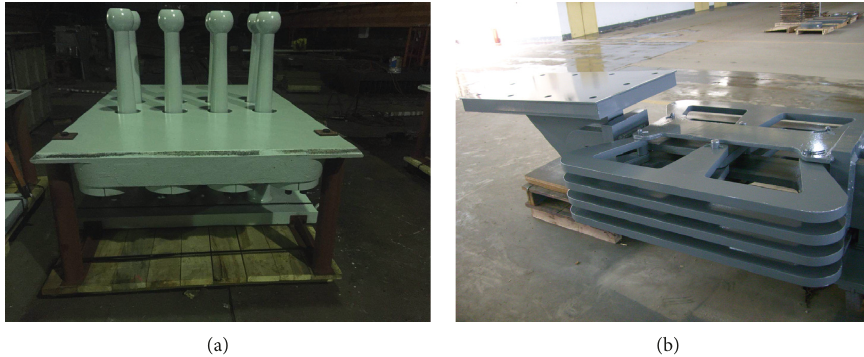
Figure 15: (a) Cylindrical and (b) E-shaped damping devices based on modular design.